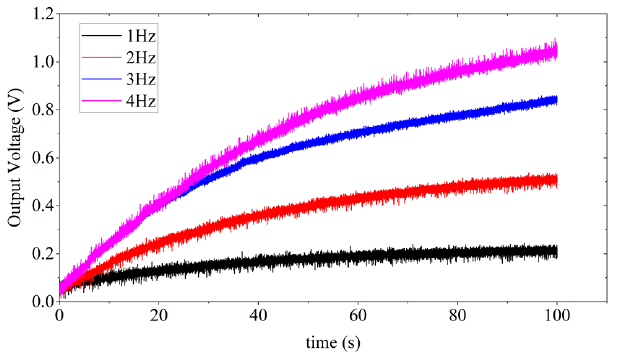
Figure 12. Charging 47 µF capacitor by triboelectric energy harvester under hand clapping movements with different frequencies (1–4 Hz).